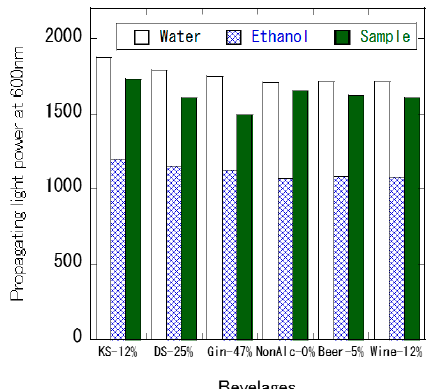
Figure 6. The propagating light intensity within various beverages. The sensor was subsequently immersed in water, ethanol, and the sample. KS–12%: Kirin Shotyu (12% ethanol); DS–25%: Daigoro-Shotyu (25% ethanol); Gin–47%: Gin (47% ethanol); NonAlc–0%: non-alcohol beer (0% ethanol); Beer–5%: beer (5% ethanol); Wine–12%: White wine (12%